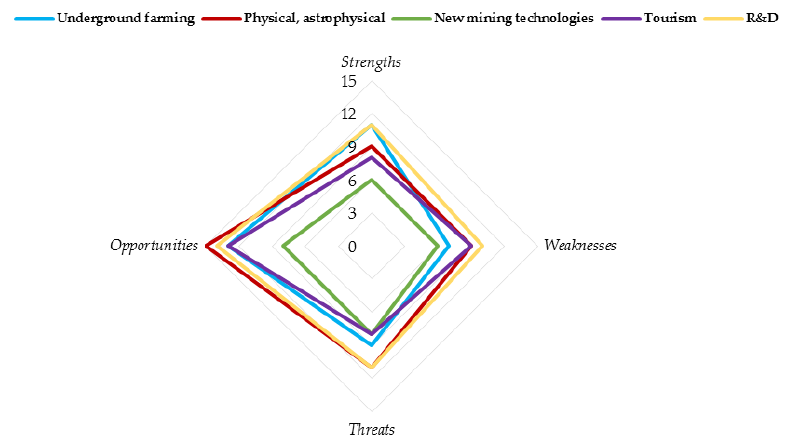
Figure 10. The quantitative results of SWOT analysis for reclamation methods aimed at adaptation and repurpose of underground workings.